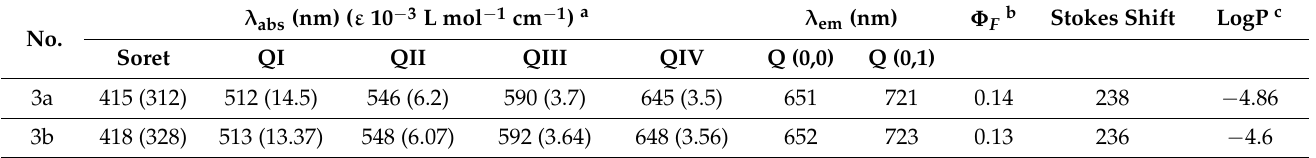
Table 1. Photophysical parameters and distribution coefficient of compounds 3a,b